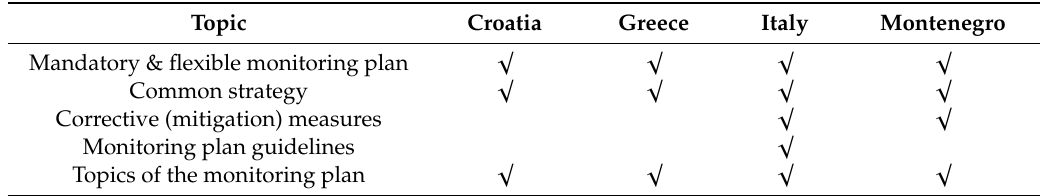
Table 2. Monitoring: main topics considered at ADRION